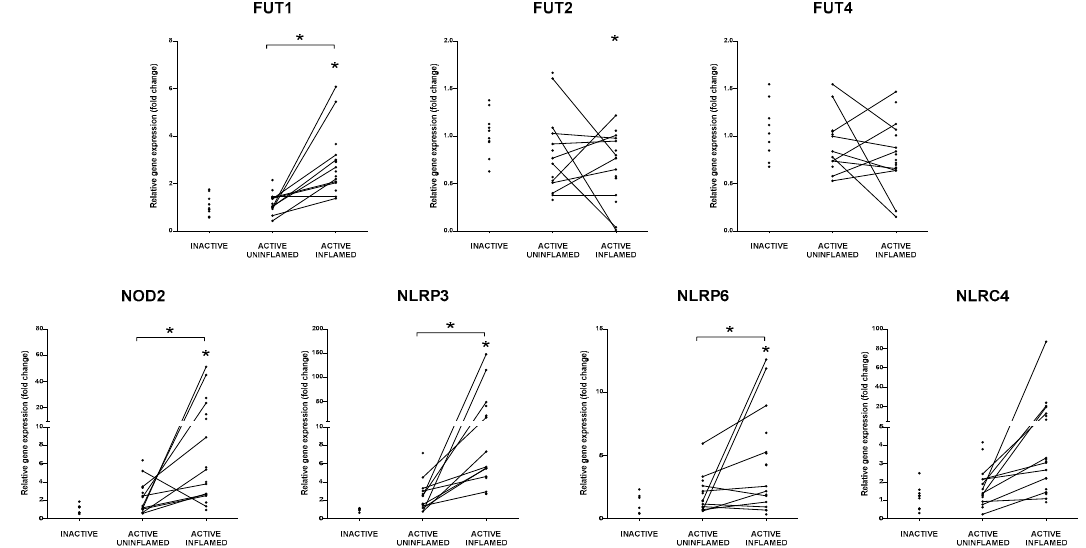
Figure 2. Distinct expression of genes regulating host-microbe interactions in IBD patients. The relative gene expression of FUTs: FUT1, FUT2, FUT4 and NLR receptors: NOD2, NLRP3, NLRP6, NLRC4 is shown from inactive (left), active uninflamed (middle) and active inflamed (right) colon samples of IBD patients. Dots represent individual values, and the lines connect uninflamed and inflamed samples from the same IBD patient; * p < 0.05.